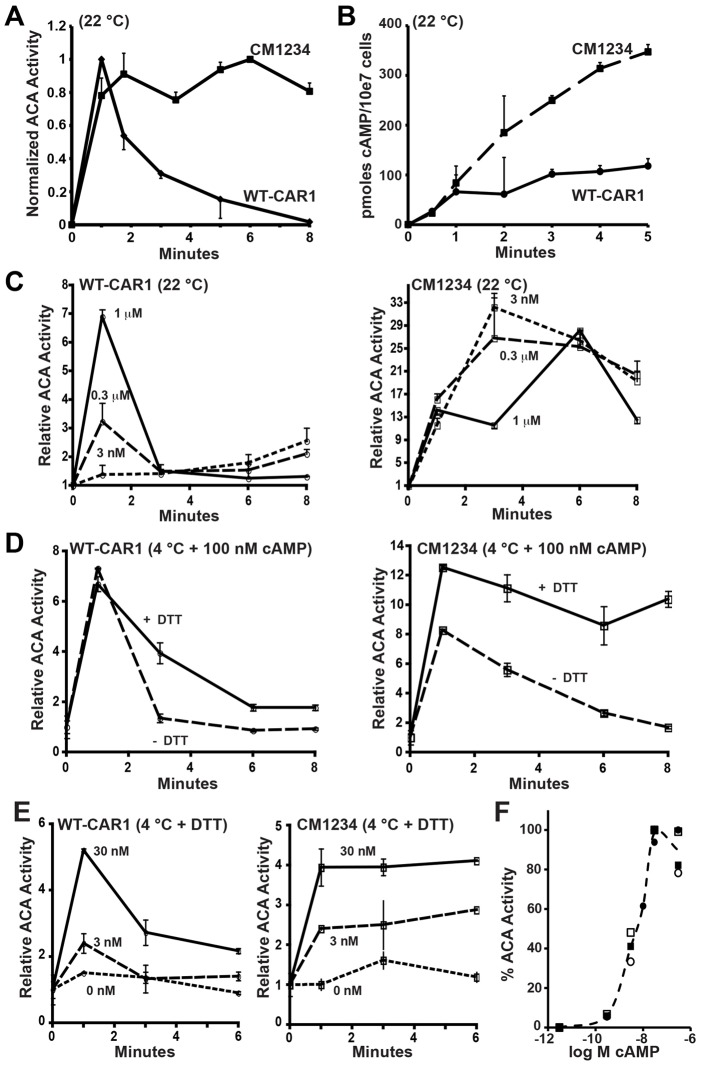
Non-adaptive response of ACA in CM1234 cells. (A) Differentiated WT-CAR1 (n = 5) and CM1234 (n = 5) cells were stimulated at 22°C with 10 µM cAMP. At the times indicated, lysates were prepared and ACA activity measured for 1 minute. Owing to the variability of total cAMP produced among the assays, background counts were subtracted from raw values and activation data (with s.e.m.) were normalized to maximal activity within each experiment. P<0.0001 by ANOVA. (B) Differentiated WT-CAR1 (n = 2) and CM1234 (n = 2) cells were stimulated at 22°C with 5 µM 2′deoxy-cAMP in the presence of 10 mM DTT. Total cAMP (with s.e.m.) was measured at the times indicated. A plateau in cAMP accumulation for WT-CAR1 cells corresponds to ACA adaptation observed at ∼1 minute (see Fig. 4A). P<0.0001 by ANOVA. C. Differentiated WT-CAR1 and CM1234 were stimulated at 22°C with varying concentrations of cAMP, as indicated. To accurately measure dose responses, a single, differentiated cell population was stimulated with the indicated concentration of cAMP, with a 20 second time lag between separate assays (see the Materials and Methods). Experiments were repeated at least twice with duplicates for each time point. Values indicate means ± s.d. (D) WT-CAR1 and CM1234 cells were differentiated, and stimulated at 4°C with 100 nM cAMP in the absence or presence of 10 mM DTT, with a 20 second time lag between each assay. At the times indicated, lysates were prepared and ACA activity assayed for 1 minute at 22°C. (E) WT-CAR1 and CM1234 cells were differentiated and stimulated at 4°C with different concentrations of cAMP in the presence of 10 mM DTT, with a 20 second time lag between each stimulation. At the times indicated, lysates were prepared and ACA activity assayed for 1 minute at 22°C. (F) WT-CAR1 (circles) or CM1234 (boxes) cells were differentiated and stimulated at 4°C in the presence of DTT with the indicated concentrations of cAMP. After 1 minute, cells were lysed and assayed for ACA activity for 1 minute. Data from two experiments (open/closed symbols) are plotted with an averaged curve fit between the points.